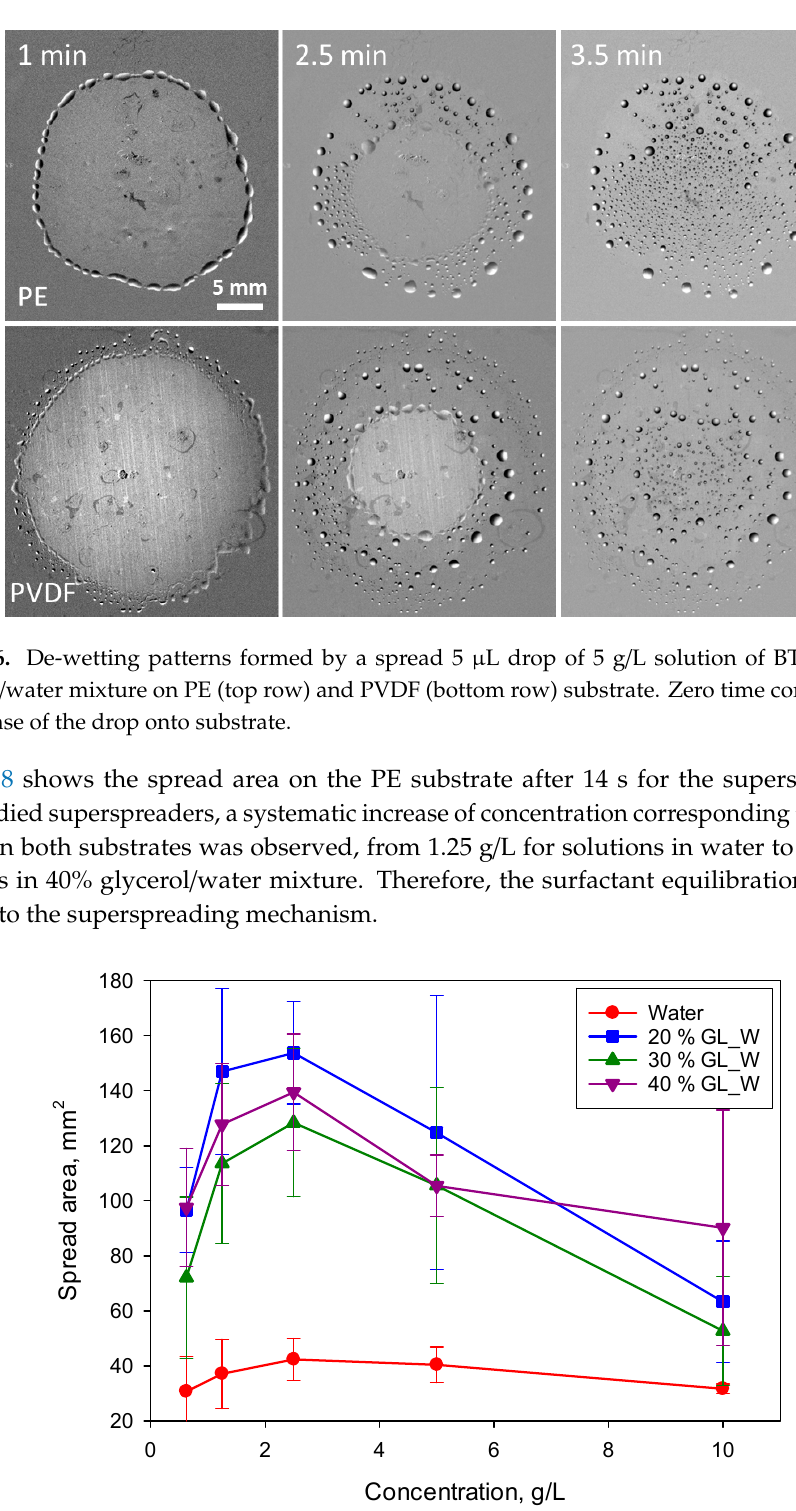
Figure 8. Dependence of the spread area on PE at t = 14 s on concentration of BT-278 in various aqueous solvents. Figure 9 presents the spreading kinetics of solutions of superspreader BT-240 in water and in 30% water/glycerol mixture. Within the time of observation, 14 s, the kinetics for solutions in water can be divided into three stages, each with distinct spreading exponents. In the first stage corresponding to t < 1 s, α is in the range of 0.3–0.5 and increasing with an increase of the concentration. The second stage of fast spreading was observed at t > 1 s with the spreading exponent depending on the concentration as shown in Table 2. This stage can be denoted as superspreading as the spreading exponent for all concentrations is higher than 0.5. The third stage occurs when the spreading slows down, with α in the range of 0.4–0.5, this was observed only for solutions in water at concentrations between 2.5–10 g/L within the time span. For these concentrations, the third stage begins at t > 5 s. The exponent for the third stage is close to the spreading exponent of the non-superspreading surfactant BT-233.